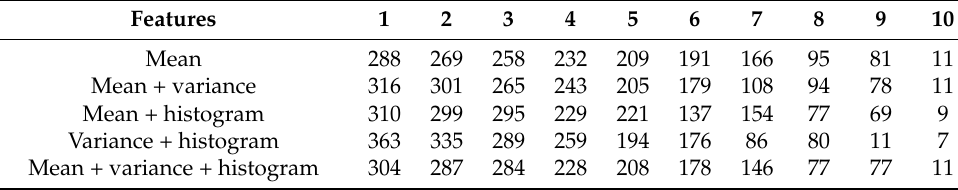
Table 4. K = 10 number of images in each cluster.